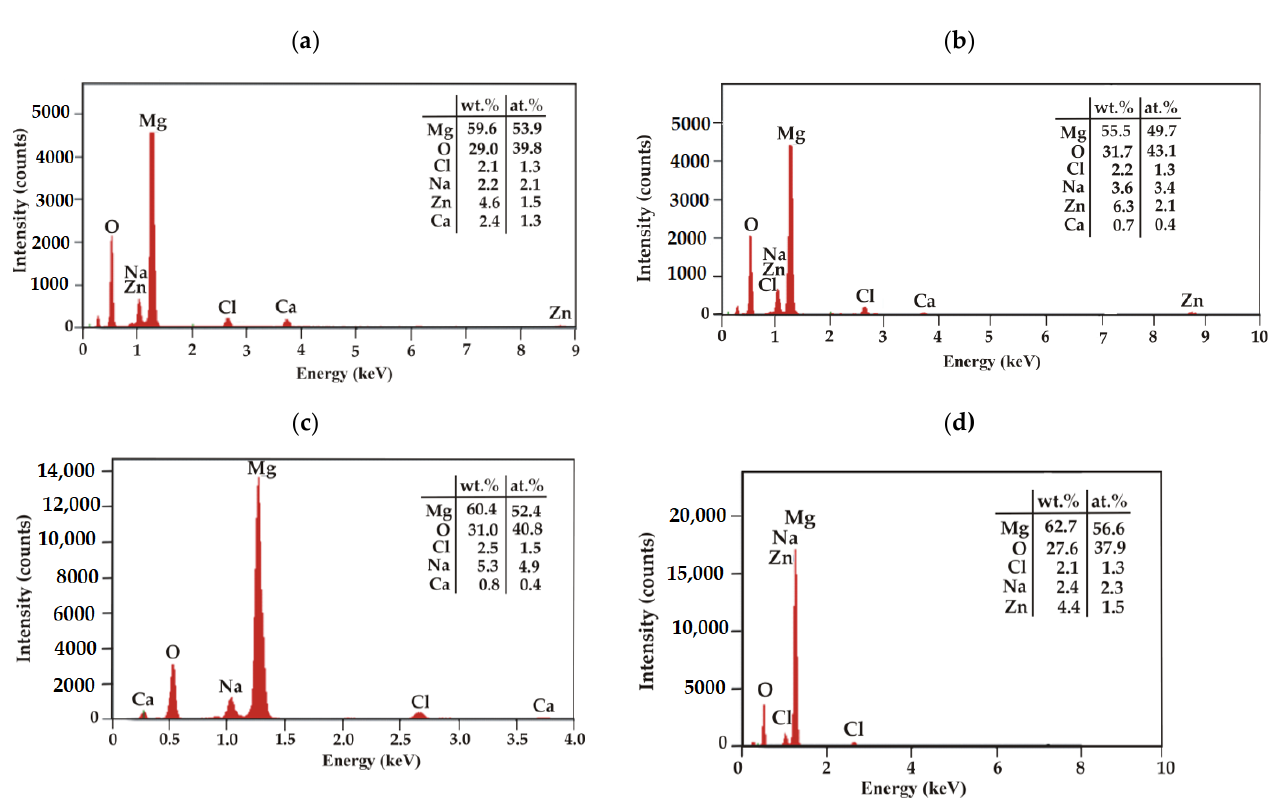
Figure 15. EDS analysis for corrosion products of the casein-free coatings (NZ) deposited on: ( a ) MgCa2Zn1; ( b ) MgCa2Zn1Gd3, and for the casein coatings (CN) applied on: ( c ) MgCa2Zn1; ( d ) MgCa2Zn1Gd3 after 48 h of immersion in Ringer solution at 37 °C.